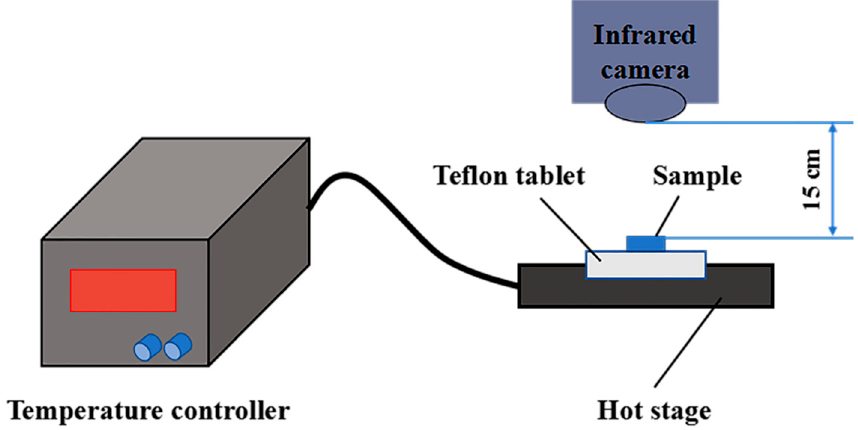
Figure 13. Schematic diagram of the test system with a hot stage to control the substrate temperature and an infrared camera (Fluke TiS65) to measure the surface temperature of the sample.